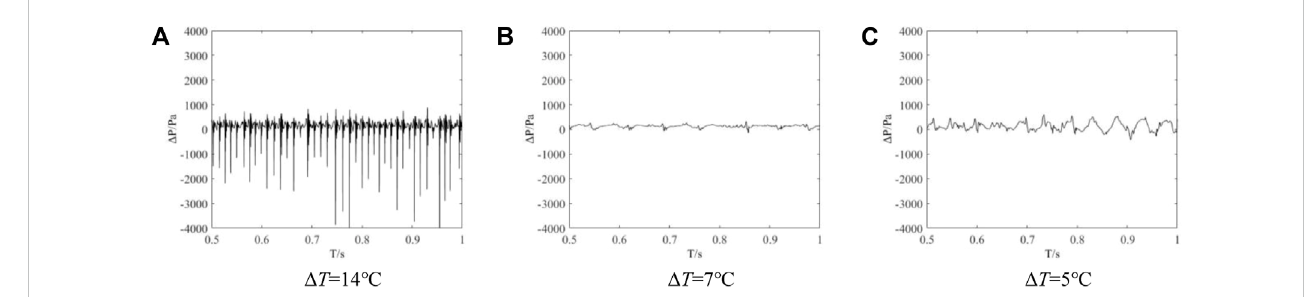
FIGURE 5 Noise time-domain signal when Ge = 70 kg/m 2 · s.